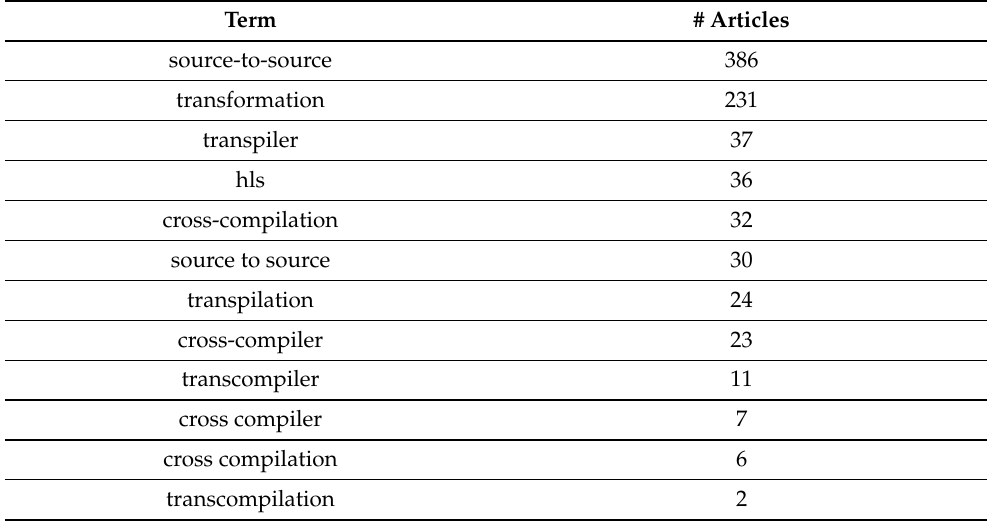
Table 16. Most-used transpiler